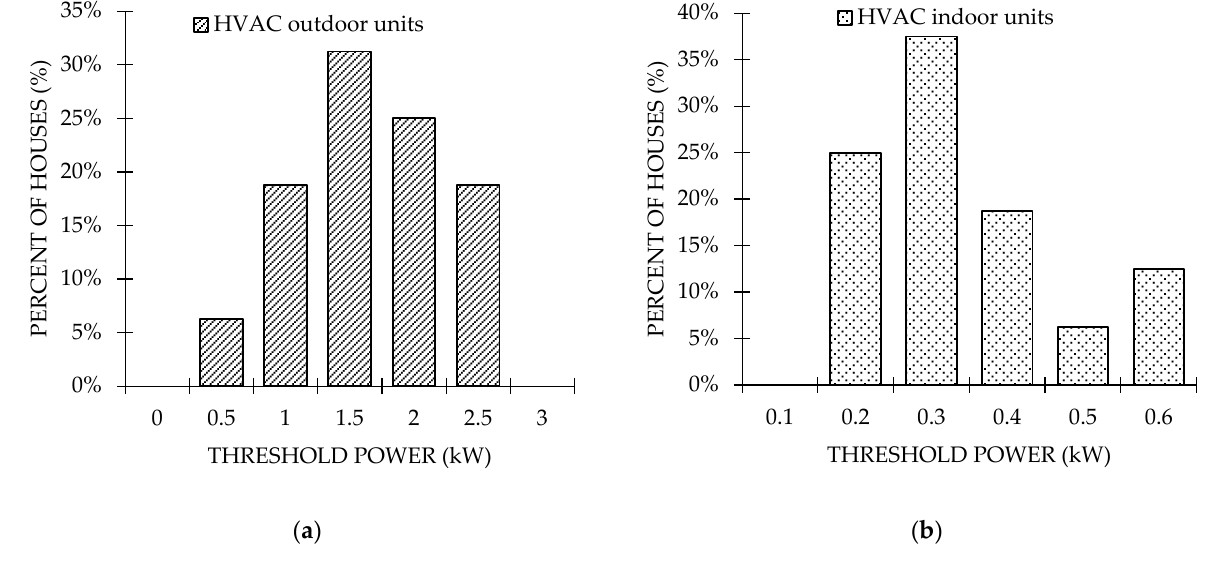
Figure 6. Histograms of threshold power for ( a ) HVAC outdoor units and ( b ) HVAC indoor units in studied residential buildings.